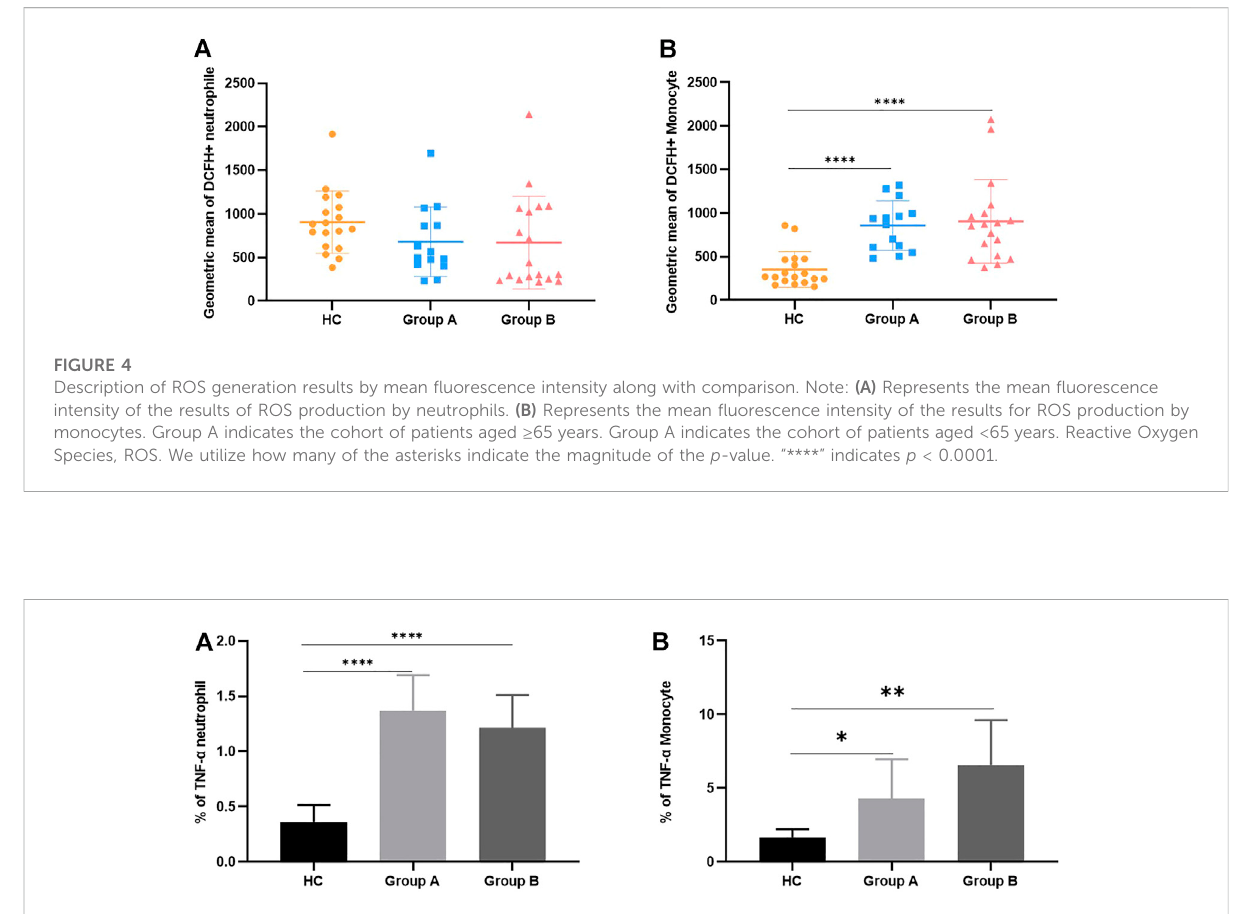
FIGURE 5 TNF- α production from neutrophils and monocytes in healthy controls and patients with abdominal sepsis of different age groups. Note: (A) represents TNF- α secretory function of neutrophils. (B) represents TNF- α secretory function of monocytes. Group A indicates the cohort of patients aged ≥ 65 years. Group A indicates thecohort of patients aged < 65 years. Tumor Necrosis Factor- alpha, TNF- α . Weutilize how many of the asterisks indicate the magnitude of the p -value. “ * ” indicates p < 0.05. “ ** ” indicates p < 0.01. “ **** ” indicates p <